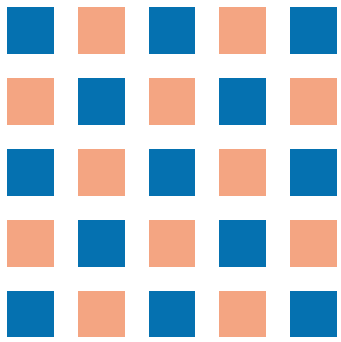
Figure 2. Visual representation of initial conditions for numerical simulations. For initial conditions, we used patches. The two subpopulations (dark and light patches) were mixed but not homogeneously